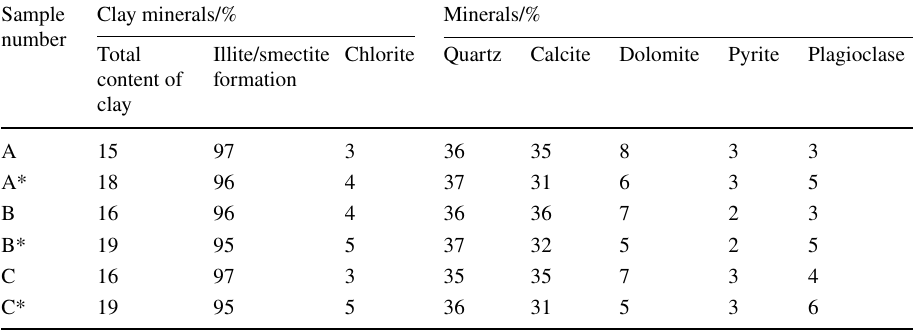
Table 5 Changes of shale mineral composition (A represents the original shale, A* represents the shale after reaction with fracturing fluid, the same